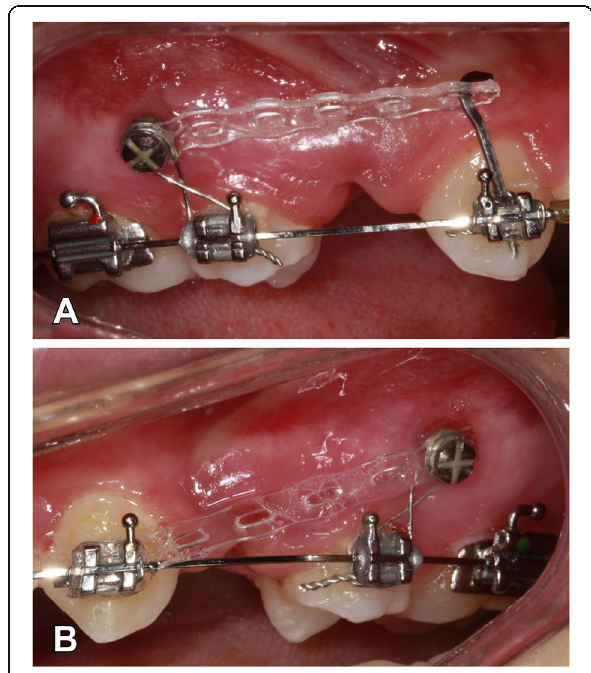
Fig. 1 A Power arm sliding mechanic. B Direct sliding